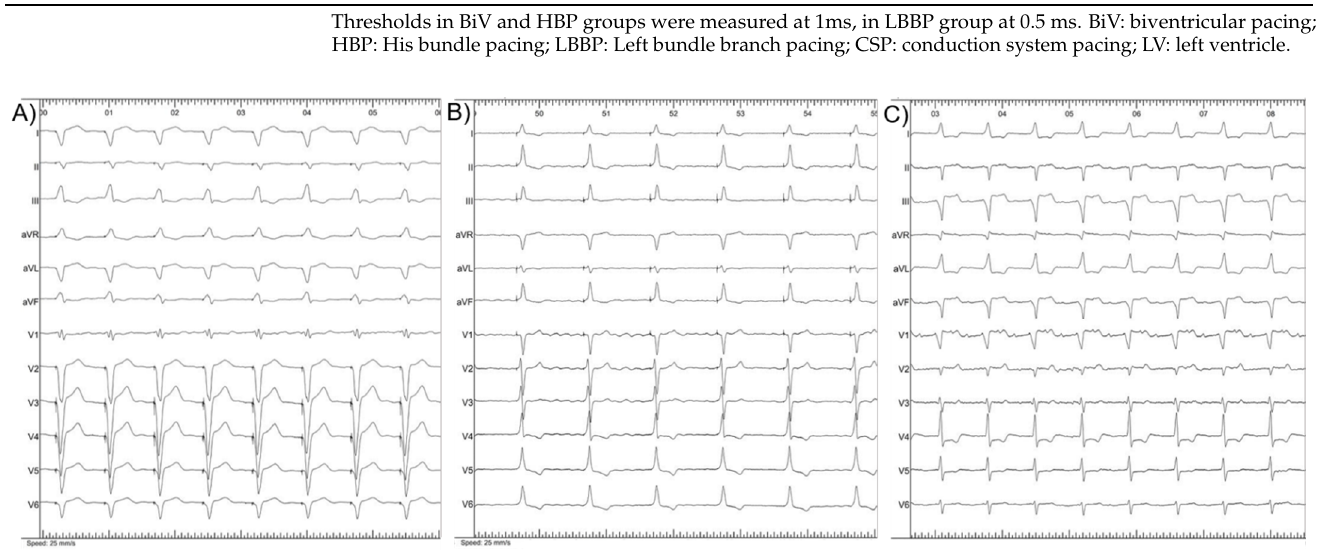
Figure 2. Post-procedural 12-lead body surface ECG of biventricular pacing ( A ), His bundle pacing ( B ) and left bundle branch pacing ( C ).